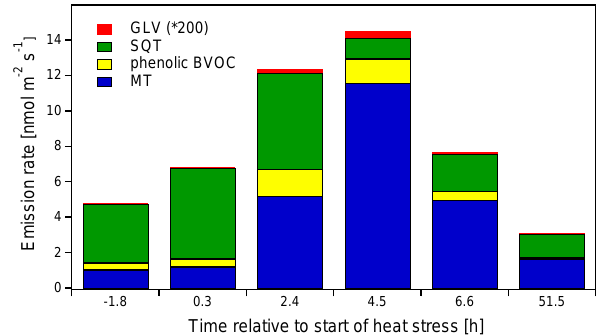
Fig. 6. Emission rates for different BVOC classes before, during and after a thermal stress application to an insect-infested pine. Blue bars = sum of MT emissions; yellow bars = sum of pheno- lic BVOC; green bars = sum of SQT emissions; red bars = sum of GLV emissions multiplied by 200 for visibility. Numbers at the x-axis indicate the time of measurement relative to starting thermal stress (46 ◦ C,